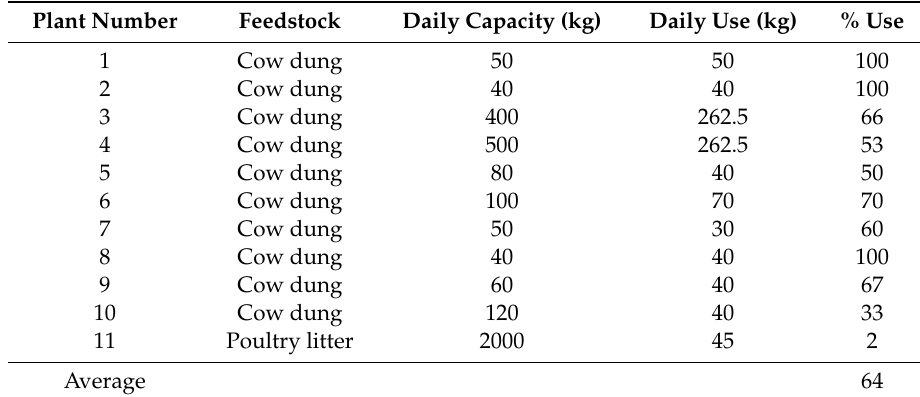
Table 4. Recorded observations of the daily feed stock supplied on-site to the biogas plants visited and compared to the amount available.